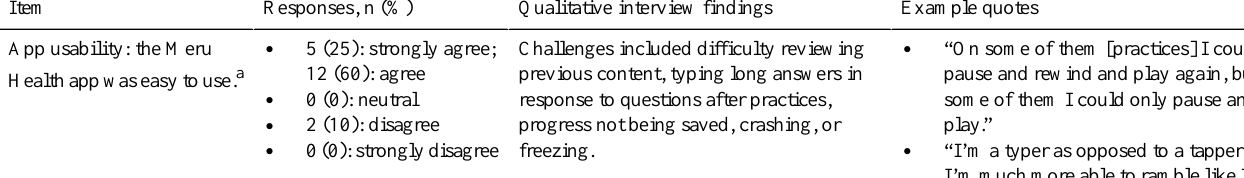
Table 2. User experience survey and qualitative interview findings.